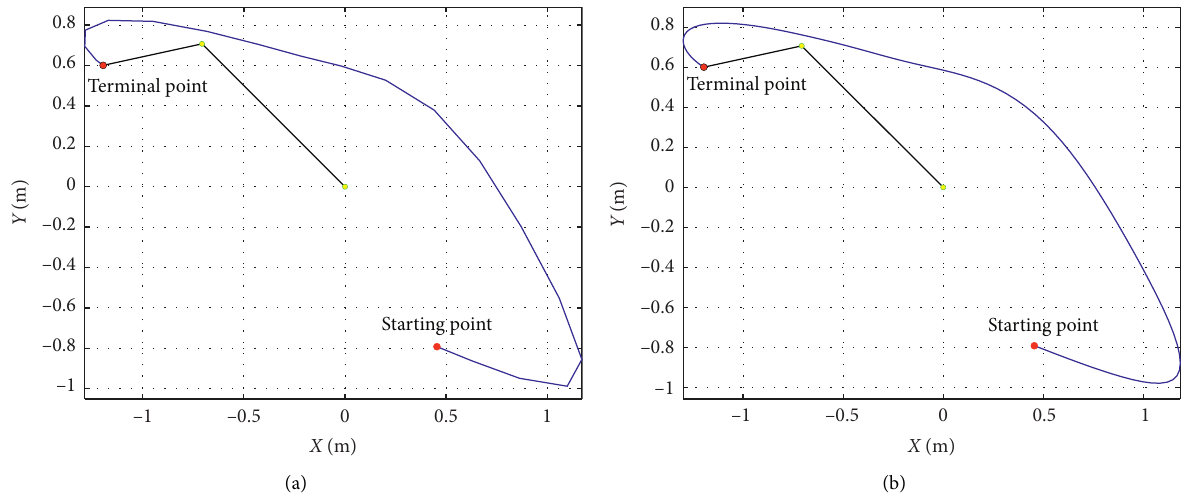
Figure 8: The trajectory of 2-DOF robotic manipulator in case 2. (a) Conventional B-spline optimization. (b) Improved B-spline optimization.